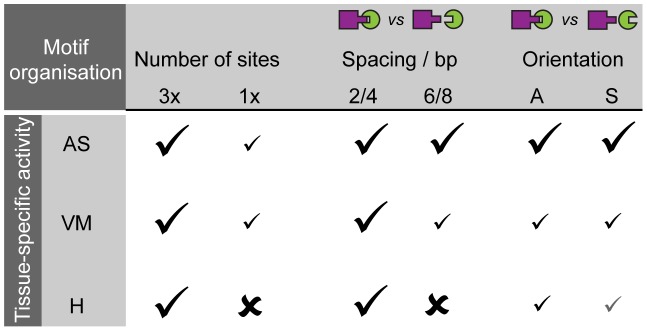
Motif organisation affects the ability of two TF motifs to elicit activity in a tissue-specific manner.Schematic table summarizing our experimental data of CRM activity for pMad-Tin CRMs, which display tissue-specific sensitivity to motif organisation (spacing, orientation) in different tissues: amnioserosa (AS), visceral mesoderm (VM) and heart (H). The effect is not always an on-off switch, but can produce a range of responses (depicted with differential strength of check marks), which affects robustness of CRM activity.